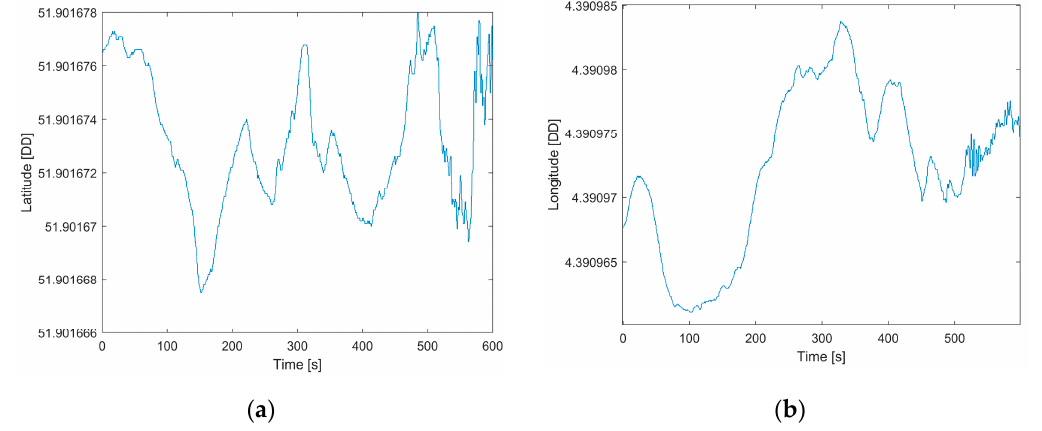
Figure 13. Position estimates (expressed in Decimal Degrees (DD): Latitude ( a ) and Longitude ( b )) provided by the proposed solutions in the test conducted in dynamic conditions. Table 8. Performance comparisons in position estimation expressed in Decimal Degrees (DD).